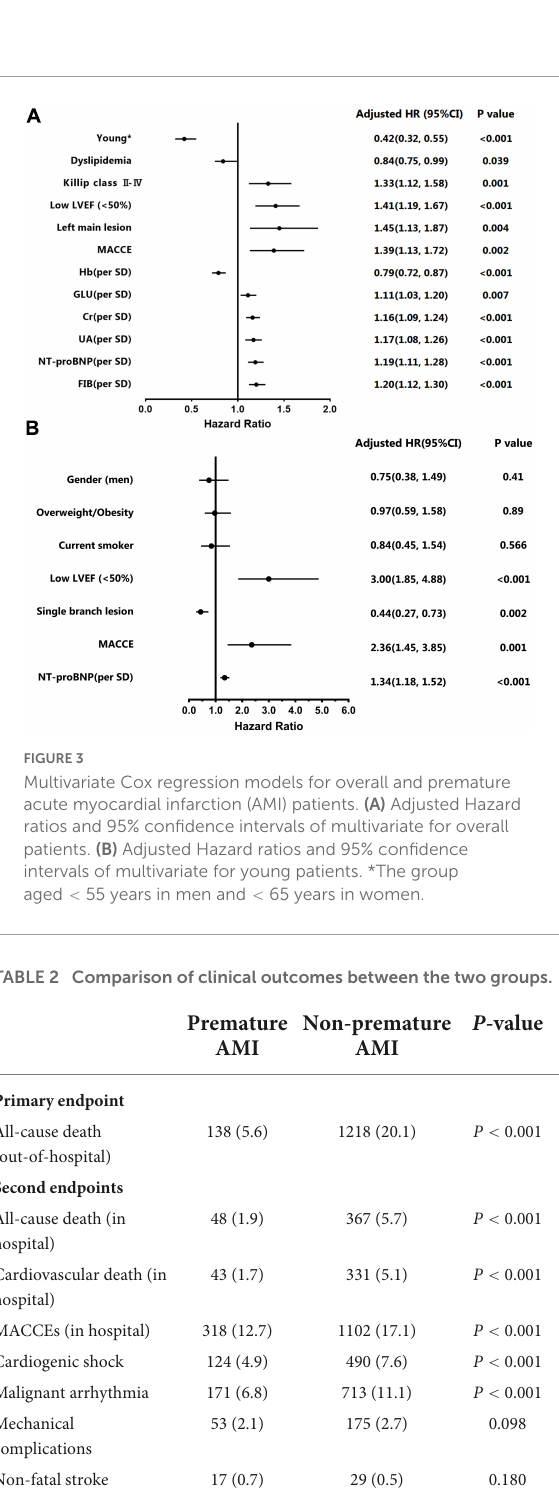
( Figure 2B ). Baseline variables considered clinically relevant